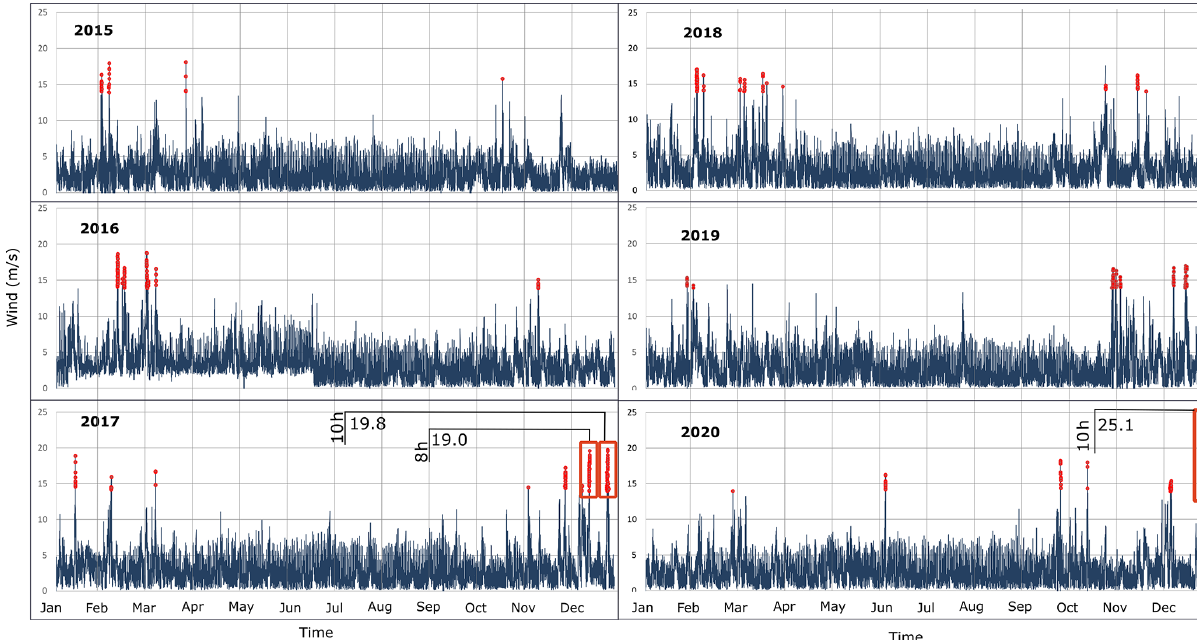
Figure 3. Graph of wind speed (m/s) between 2015 and 2020 measured by the P01 weather station; red points highlight storms from 202– 242 ◦ with velocity > 13 . 9m/s.